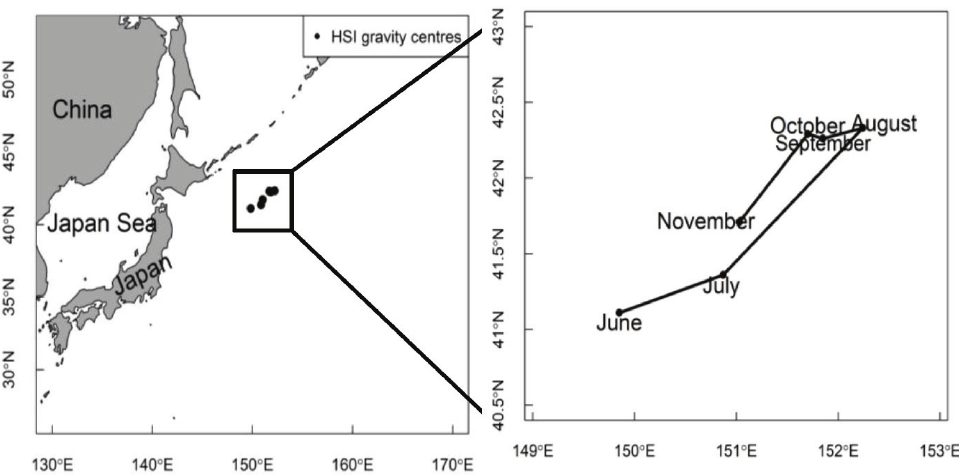
Figure 7. Variation of the geometric centers of the HSI between June and November from 2015 to 2020.